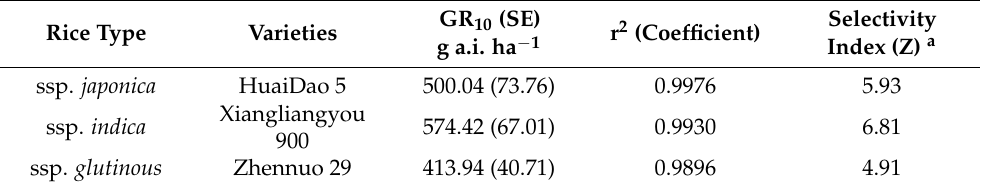
Table 5. Selectivity index of Glyamifop between rice and